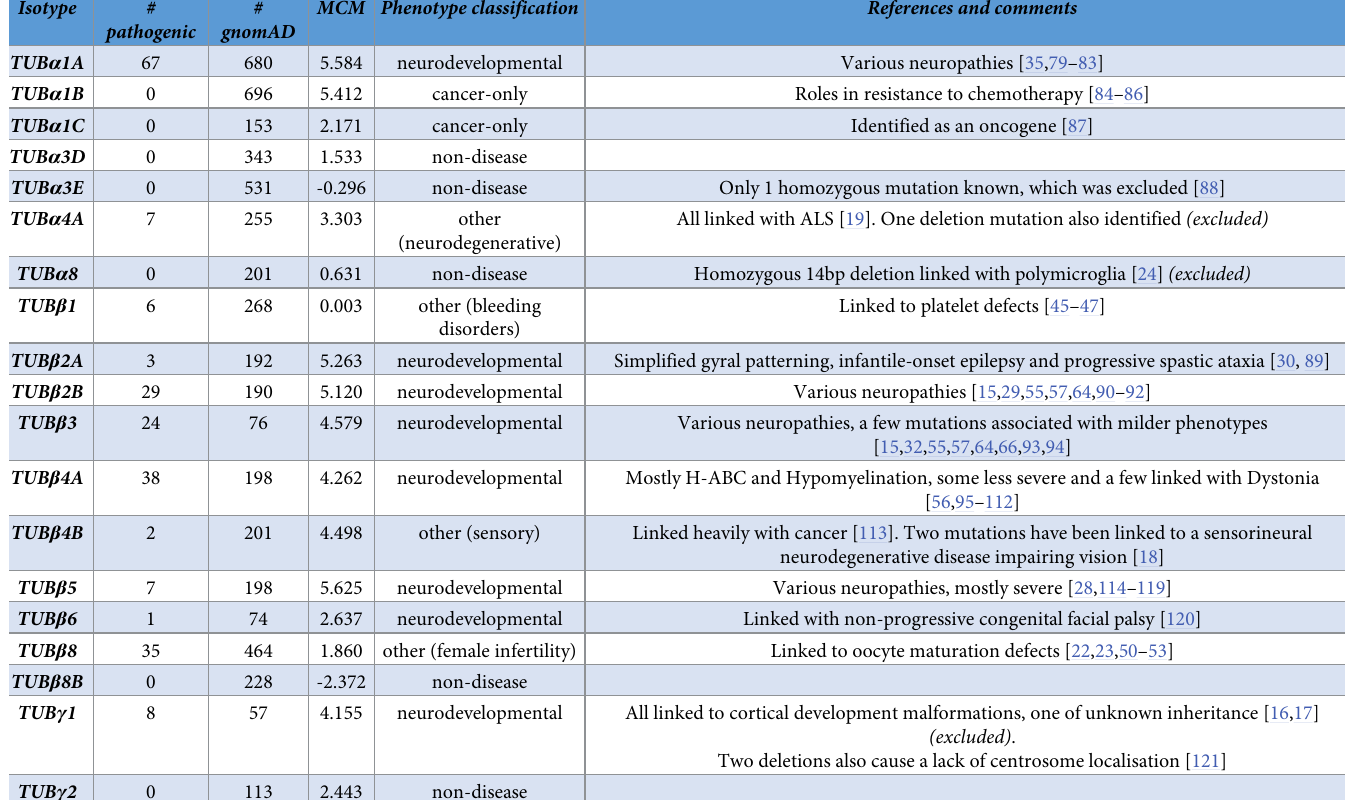
Table 1. Summary of all tubulin isotypes considered for this study. The number of dominant pathogenic mutations identified for each isotype is denoted, as well as their pathogenicity classification. Where necessary, additional comments about the pathogenicity type and references for all mutations are also included. MCM = missense constraint metric (Z-Score obtained from gnomAD); ALS = amyotrophic lateral sclerosis; H-ABC = hypomyelination with atrophy of basal ganglia and cerebellum.